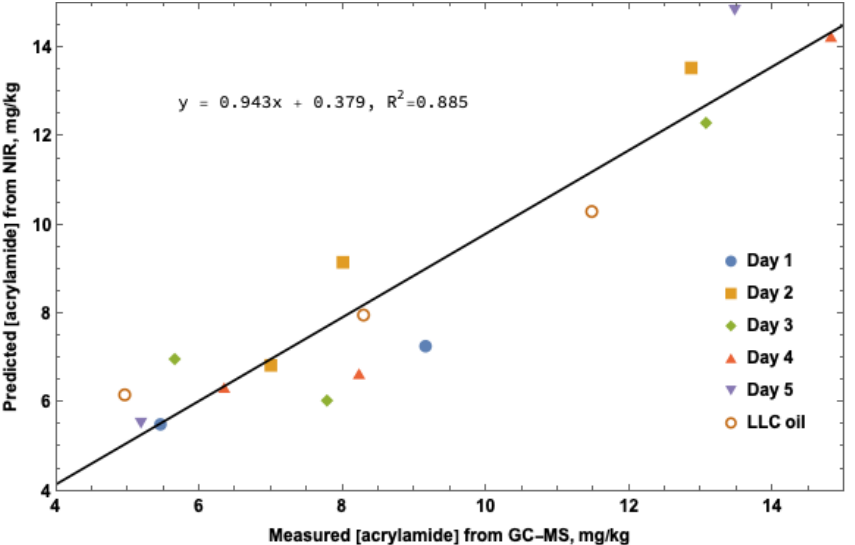
Figure 2. NIR acrylamide prediction. Predicted acrylamide concentration from NIR spectral data as compared to actual acrylamide concentration in mg/kg measured by GC-MS.